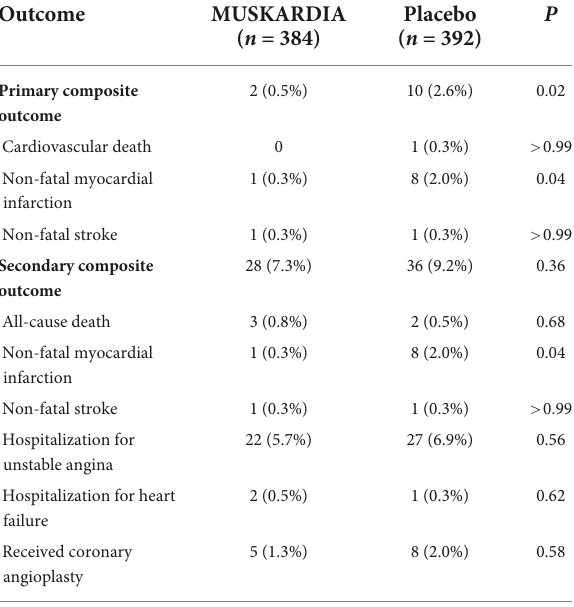
TABLE 2 Efficacy